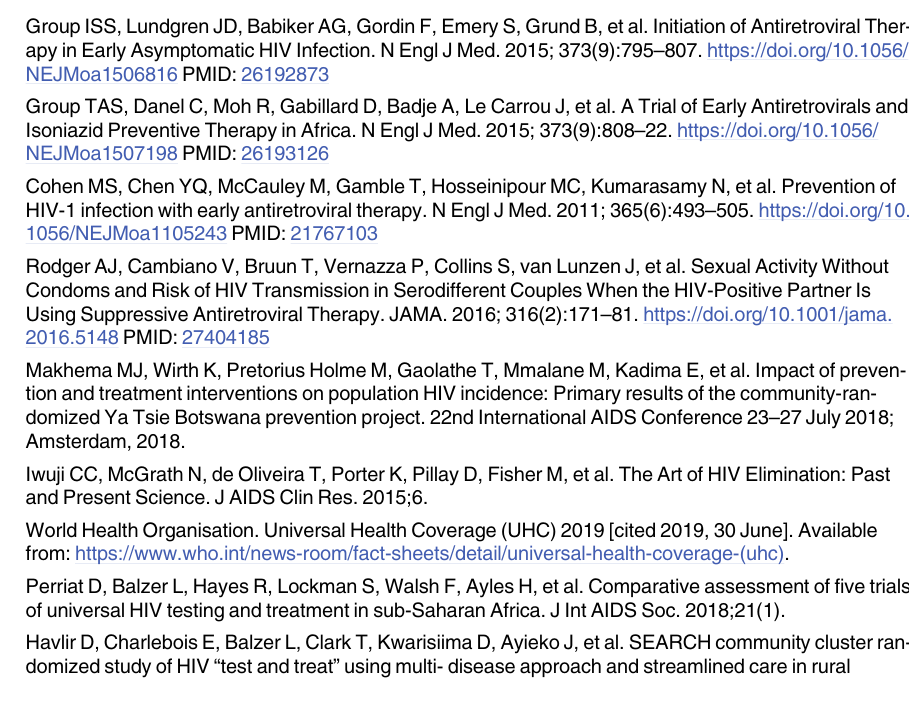
S1 Table. Barriers and facilitators -repeat individual in-depth interviews. (PDF) S2 Table. Barriers and facilitators-focus group discussions and individual interviews.